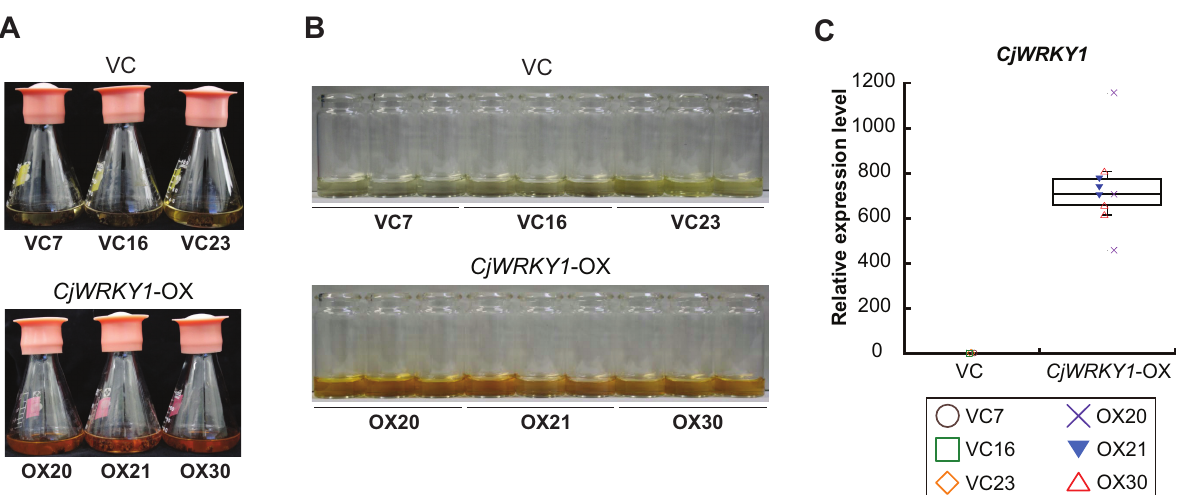
Fig 2. CjWRKY1 -overexpressing transgenic California poppy cells were established. (A) Three transgenic cell lines were cultured for 5 days. (B) The medium from CjWRKY1 -OX cell lines showedclear brown pigmentation. (C) Constitutive expressionof CjWRKY1 in transgeniccell lines. The transcript level of CjWRKY1 was determined by quantitative RT-PCR. Nine biologicalreplicateswere used of each cell line.